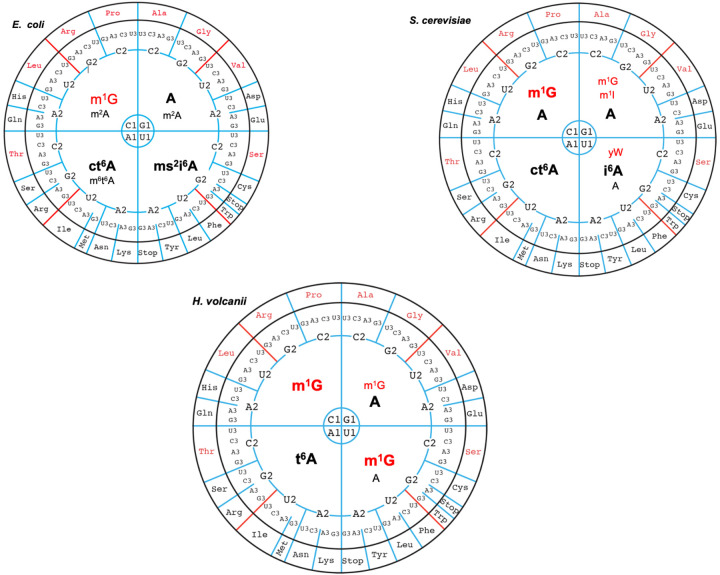
Patterns of distribution of modified nucleotides at position 37 in E. coli, S. cerevisiae and five archaeal species on the wheels of the genetic code (Grosjean and Westhof 2016). In that representation, GC-rich codons are at the top and AU-rich at the bottom of the wheel. The codon positions are numbered 1, 2, 3 so that G1A2C3 gives an Asp codon. The four quadrants are characterized by the first codon position. Data for E. coli and S. cerevisiae are from MODOMICS (Boccaletto et al. 2018). Data for H. volcanii are from Gupta (1984, 1986) and Grosjean et al. (2008a), data for M. jannaschii are from Yu et al. (2019). The wheels for E. coli, S. cerevisiae, and H. volcanii are adapted from Grosjean and Westhof (2016). In each quadrant, the observed modified nucleotides at position 37 are shown (red for G derivatives and black for A derivatives; the very unusual U37 of tRNA-Ala(GGC) of M. jannaschii is also shown in black). The modifications observed frequently have a large font and are bold, while those observed only once or in a single tRNA species have a smaller font and are not bold.